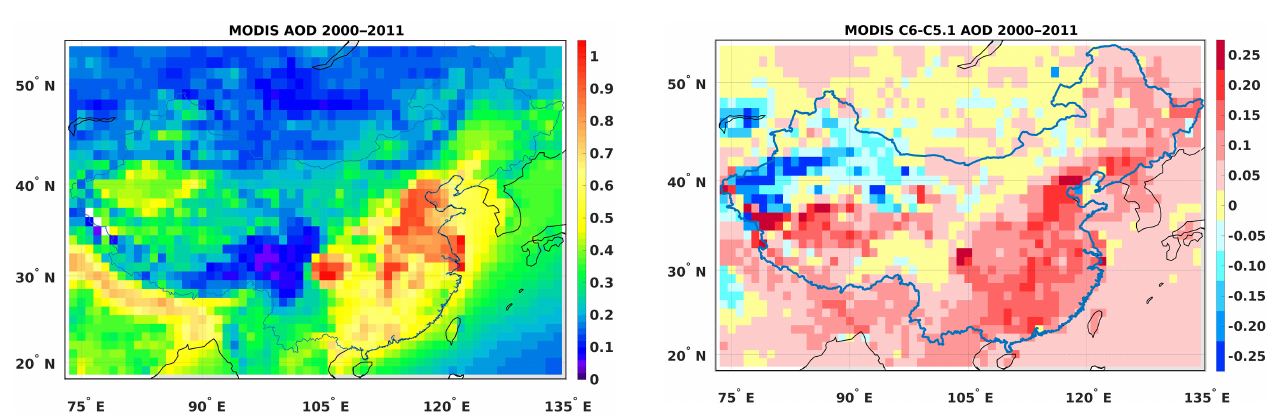
Figure 3. Spatial distribution of the MODIS/Terra C6 merged DTDB AOD over China, aggregated for the full years 2000–2011.